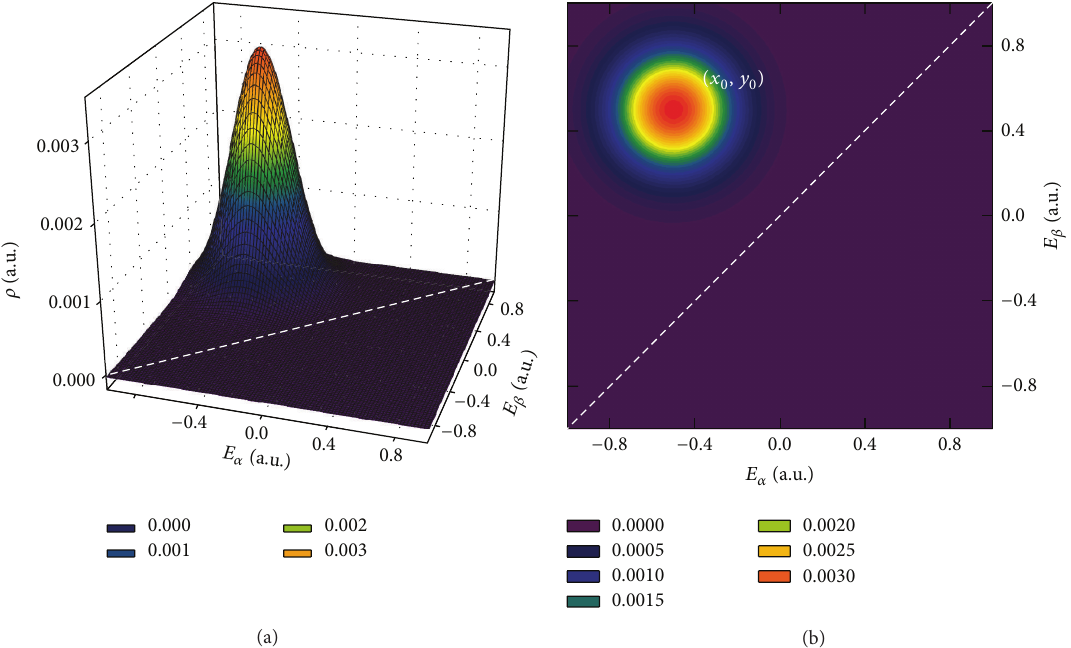
Figure 2: Illustrations of (a) Gaussian-defined Preisach density and (b) contour plot of the three-dimensional density in (a), where (𝑥 0 , 𝑦 0 ) indicates a center of the